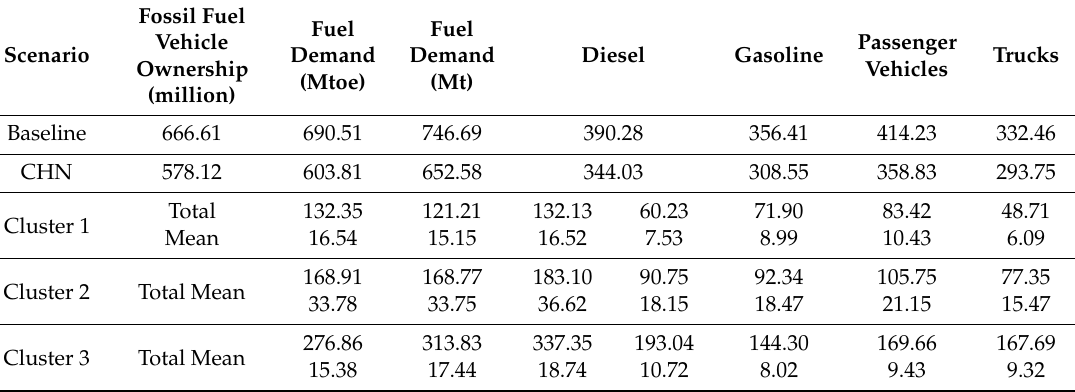
Table 9. Fuel demand with di ff erent substitution speeds.